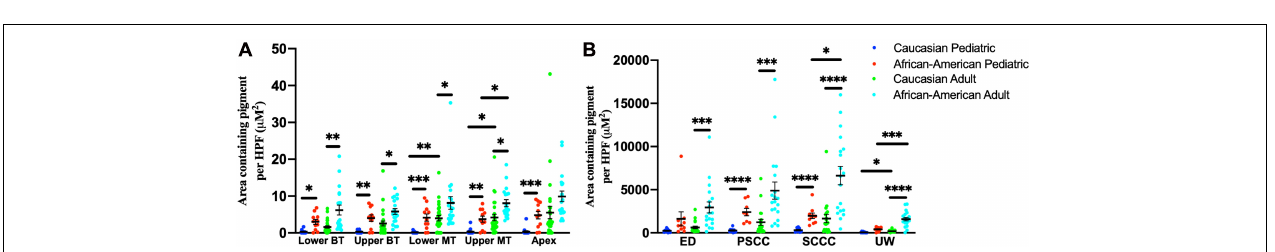
FIGURE 5 | Pigmentation within the vestibular system in human (A) and mouse (B) temporal bones. Error bars indicate standard error. ED, endolymphatic duct; PSCC, posterior semicircular canal; SCCC, superior semicircular canal; UW, utricle wall. ∗∗ Adjusted p -value < 0.01.